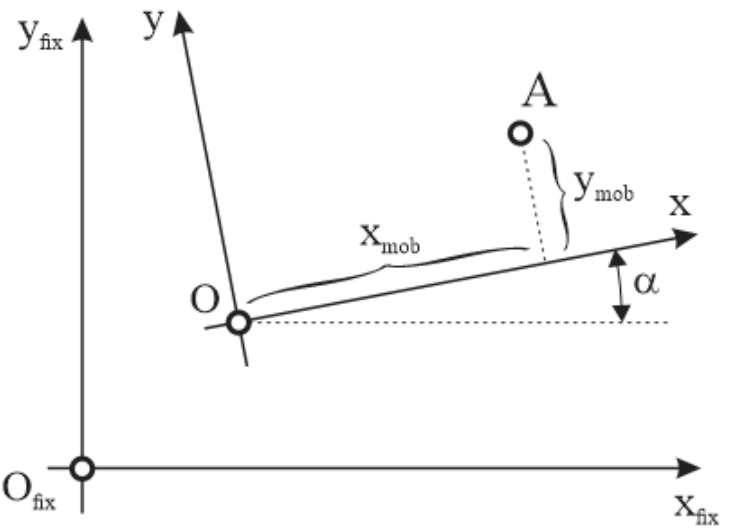
Figure 9. The representation of the two fixed and mobile coordinate systems is necessary for the schematic description of the analytical calculation algorithm.